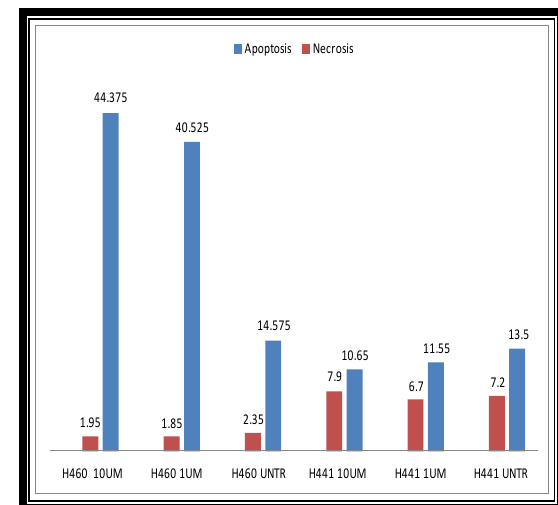
Figure 6 : Apoptosis and necrosis percentages after 48 hr of nicotine treatment with concentrations (1 μ M and 10 μ M) in H460 and H441 lung cancer